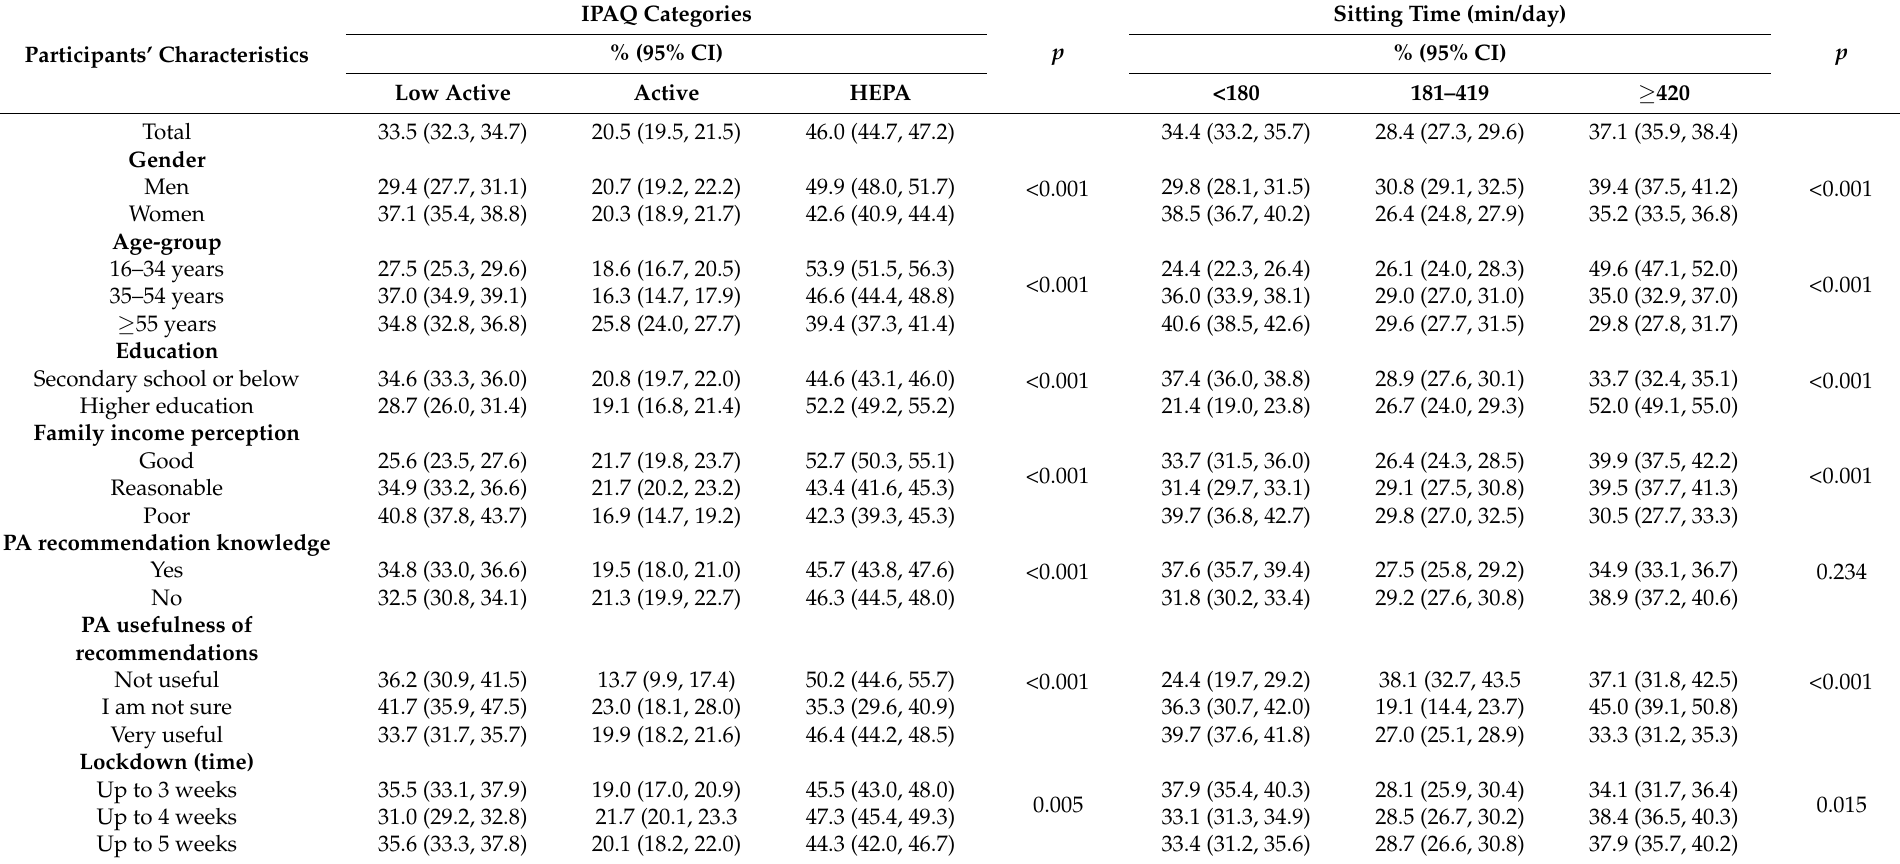
Table 2. Prevalence of physical activity and time spent sitting, during the COVID-19 social